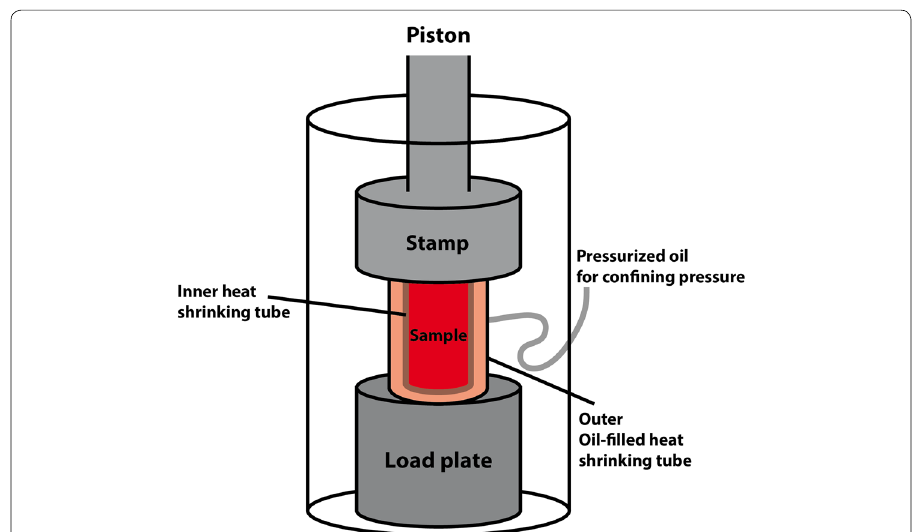
Fig. 2 Schematic triaxial testing device with its main